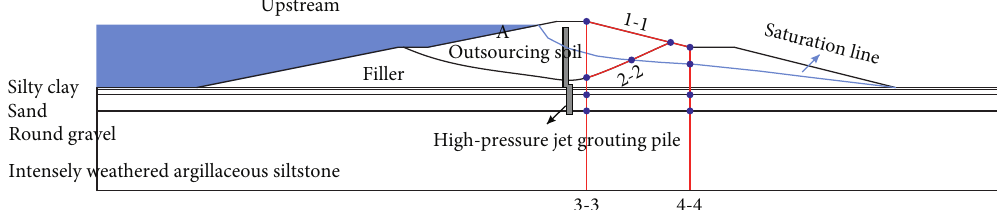
Figure 8: Schematic diagram of selection of cofferdam deformation analysis points underwater-level